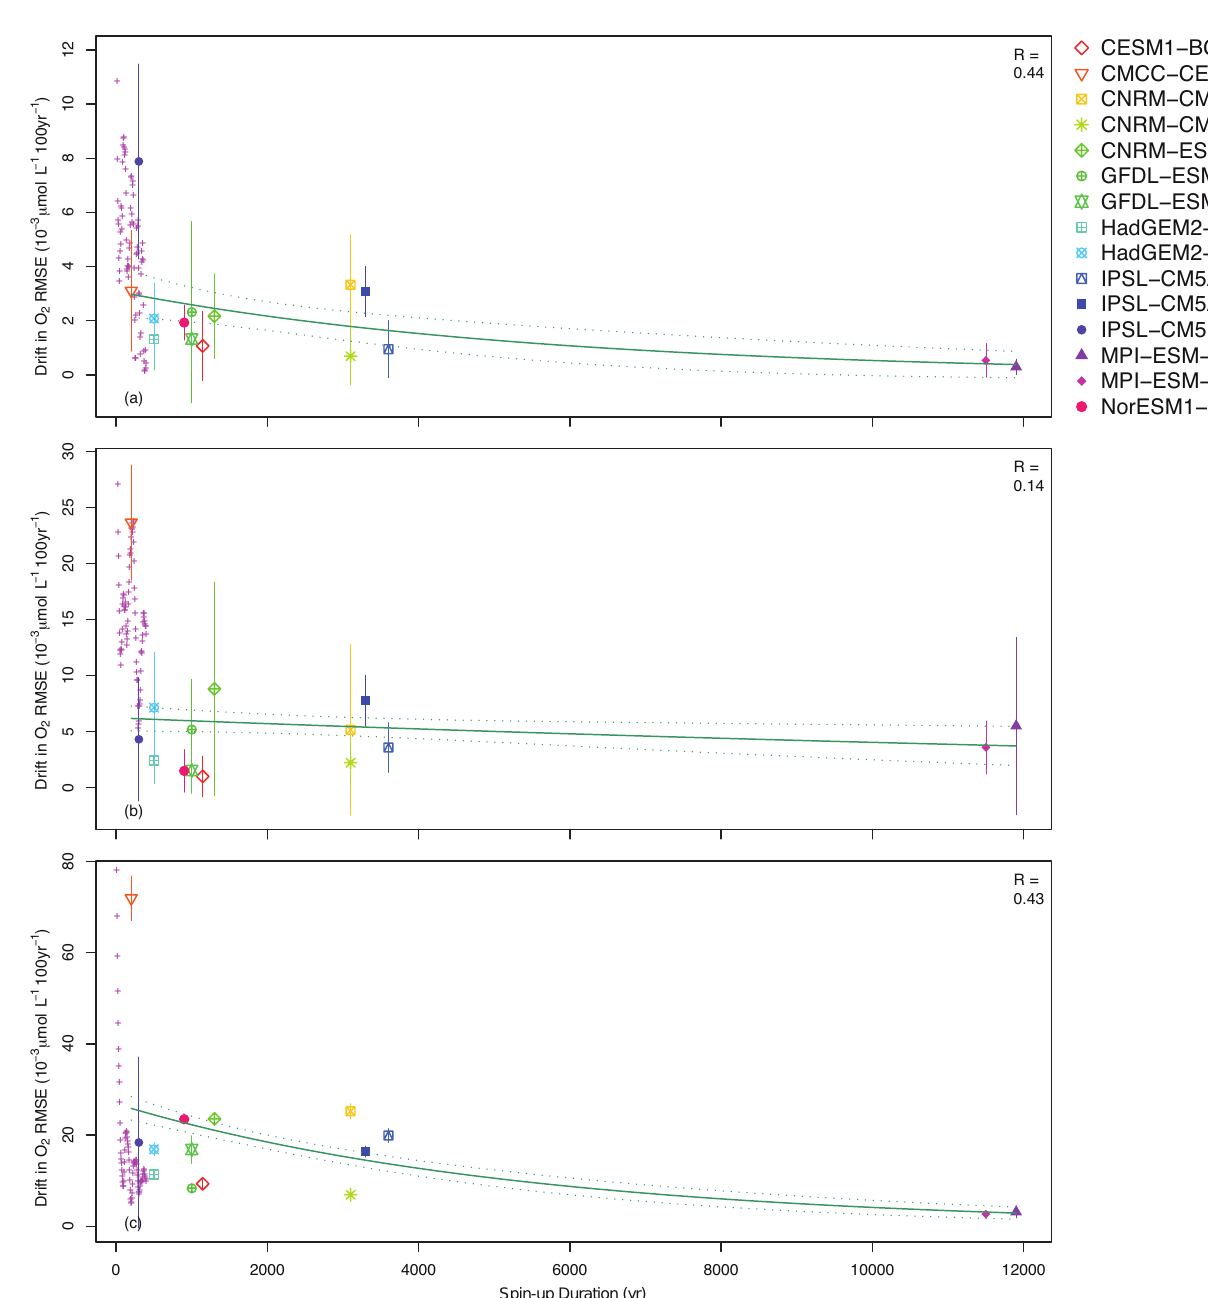
Figure 9. Scatterplot of drifts in root-mean squared error (RMSE) in O 2 concentration vs. the duration of the spin-up simulation for the available CMIP5 Earth system models. Drifts in O 2 RMSE are respectively given for surface (a) , 150m (b) and 2000m (c) for oxygen concentrations. Drift in O 2 RMSE is computed from several time segments of 100 years beginning every 5 years from the beginning until the end of the piControl simulation for the available CMIP5 models. Colored symbols indicate the mean drift in O 2 RMSE, while vertical lines represent the associated 90% confidence interval. The best-fit regressions between models’ mean drifts in RMSE and spin-up duration are indicated as solid green lines; their 90% confidence intervals are given by thin dashed envelopes. Fits are assumed robust if correlation coefficients are significant at 90% (i.e., r ∗ >0.34). For comparison, drift in O 2 RMSE from our spin-up simulation with IPSL-CM5A-LR (Fig. 8) are represented by magenta